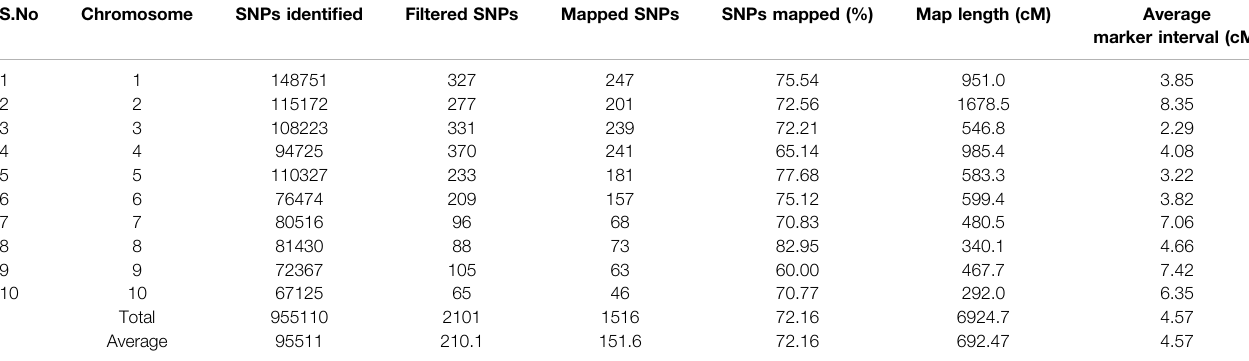
TABLE 2 | Characteristics of genetic linkage map constructed using recombinant inbred line (RIL) population derived from a cross of UMI79 × UMI936 (w). S.No